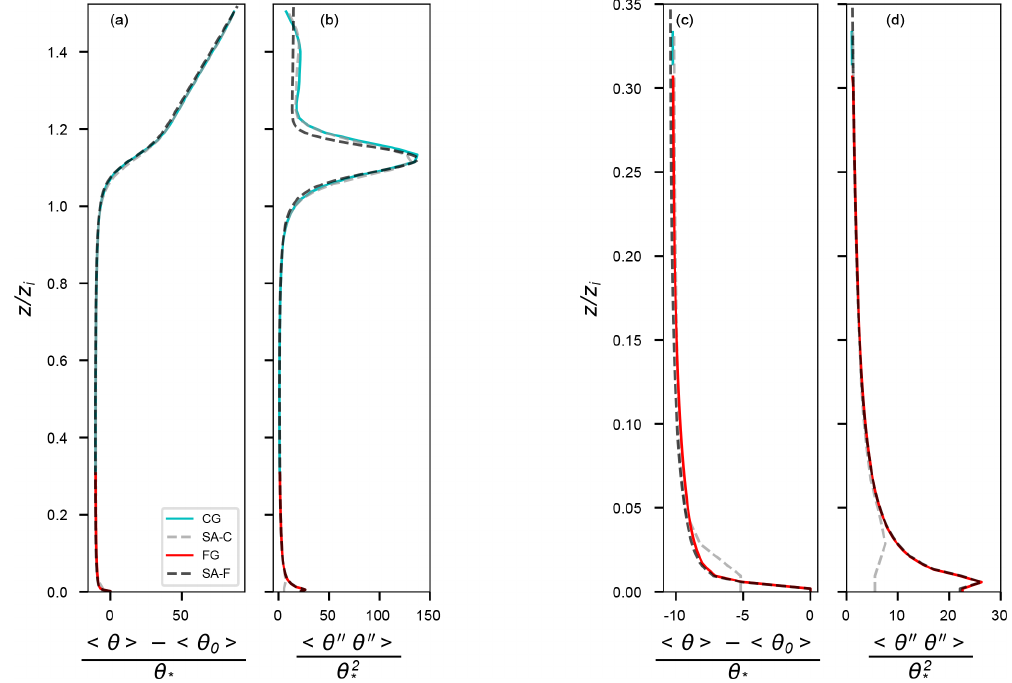
Figure 5. Vertical profile of horizontally averaged potential temperature normalized by the surface value (a, c) and variance of potential temperature normalized by θ 2 ∗ (b, d) . The nested grid profiles agree well with the SA-F in the surface layer. The improvement of the two-way nesting, at the boundary layer height, is seen in the good agreement in the profiles of CG and SA-F in (b)